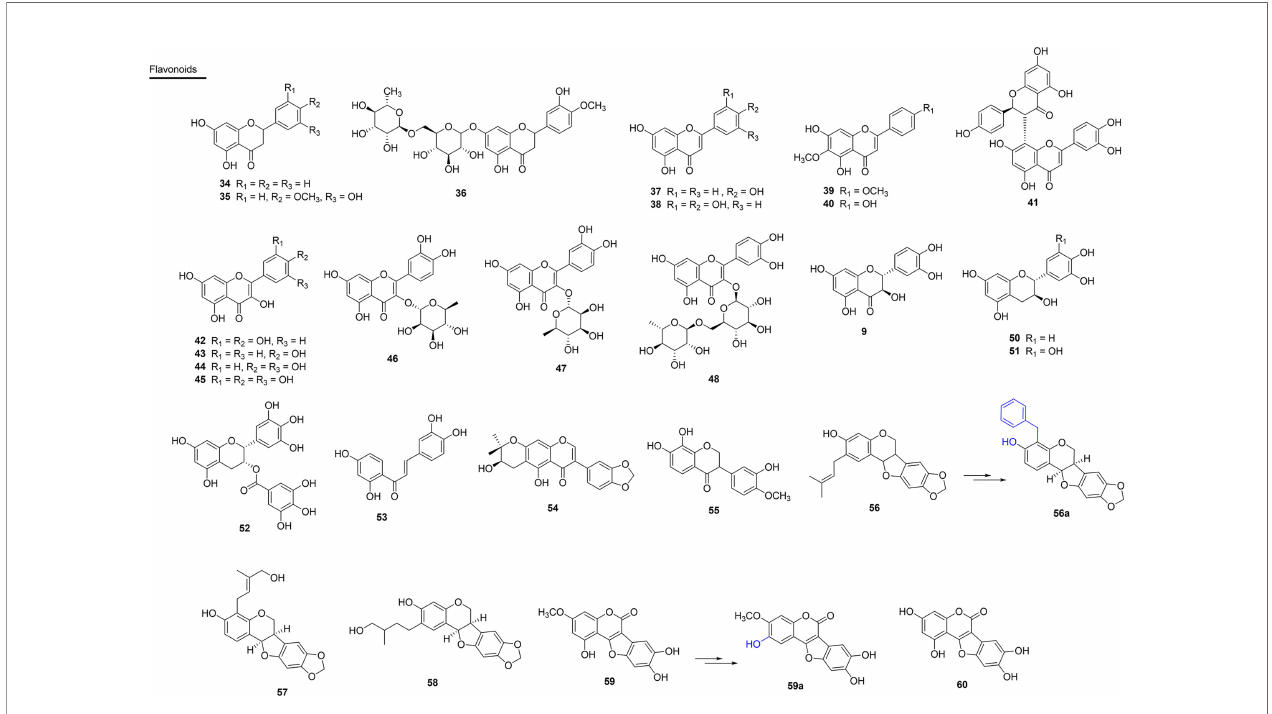
FIGURE 6 | Chemical structures of snakebite treatment compounds 34-60